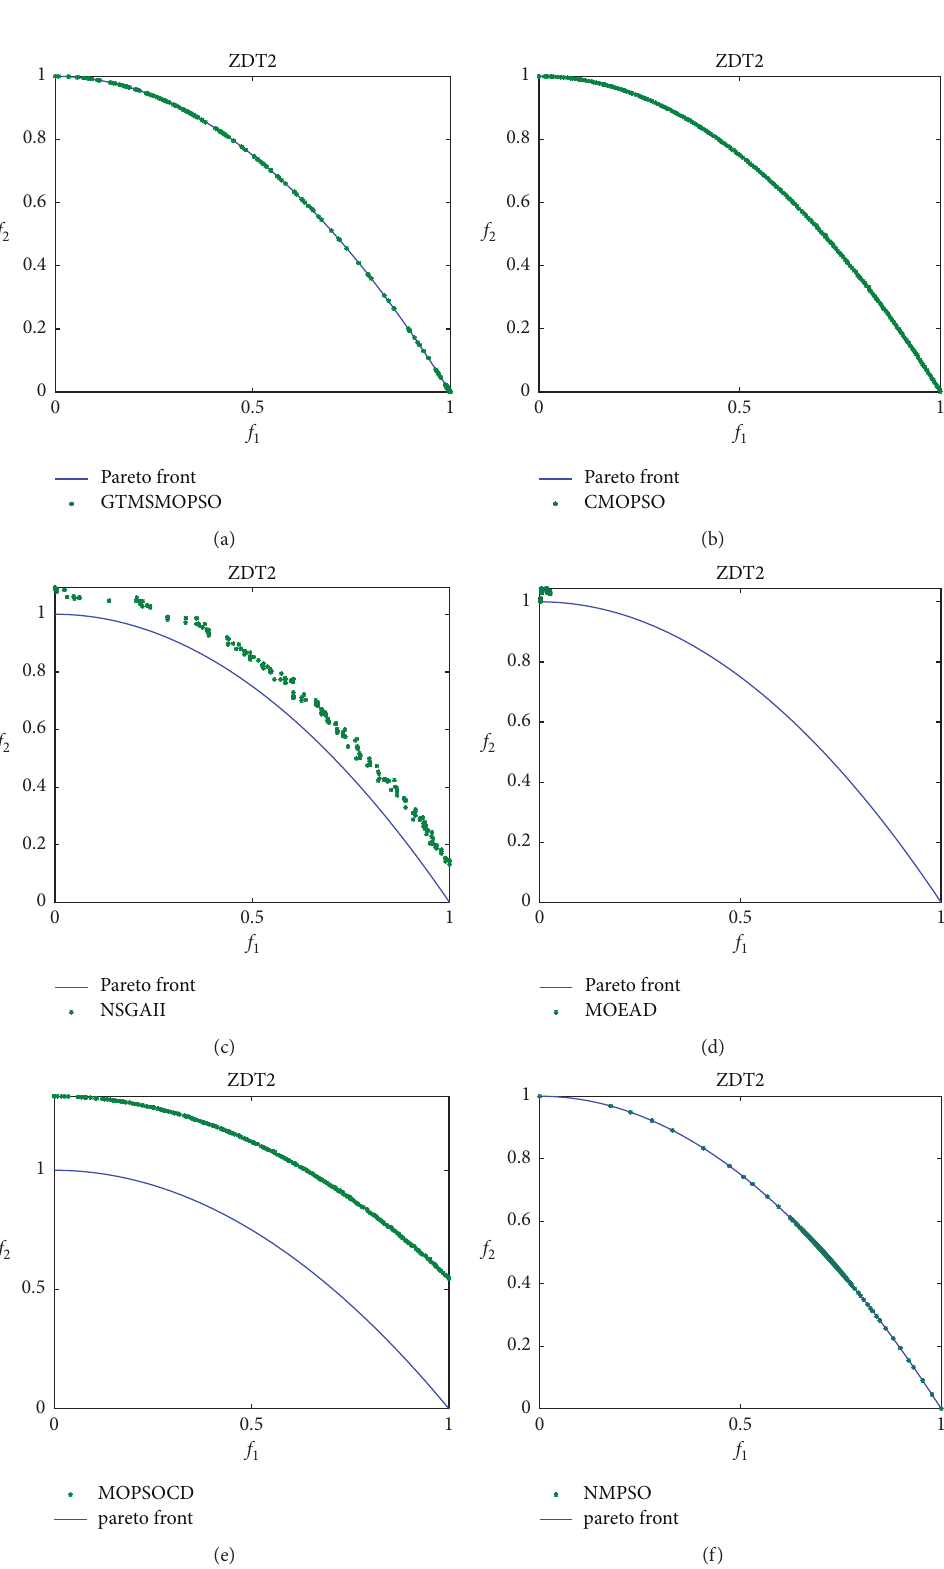
Figure 4: Pareto frontier effect of three different algorithms for ZDT2